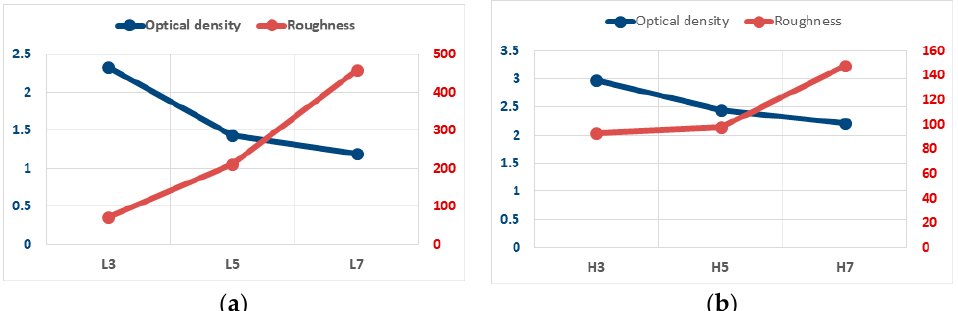
Figure 8. Comparison of OD on the 3rd day and roughness values in the L group ( a ) and H group ( b )